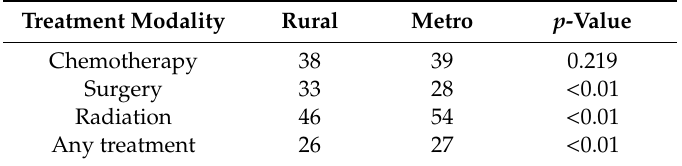
Table 3. Median time to initiate therapy from the time of diagnosis of gastric adenocarcinoma (in days), in rural versus metro patient